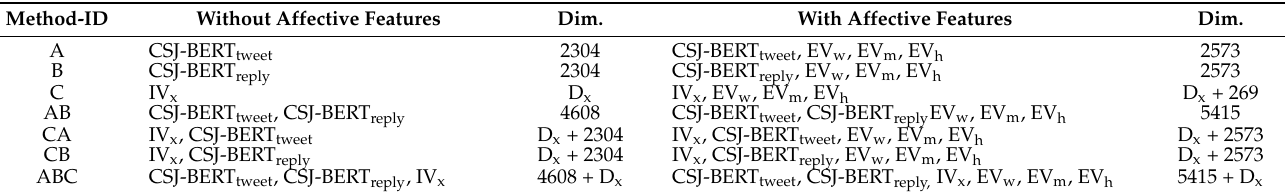
Table 2. Combinations of feature used in the proposed methods.